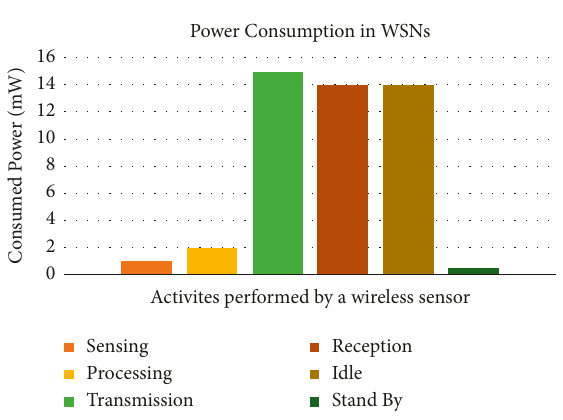
Figure 4: Power consumption in WSNs of a sensor node’s components